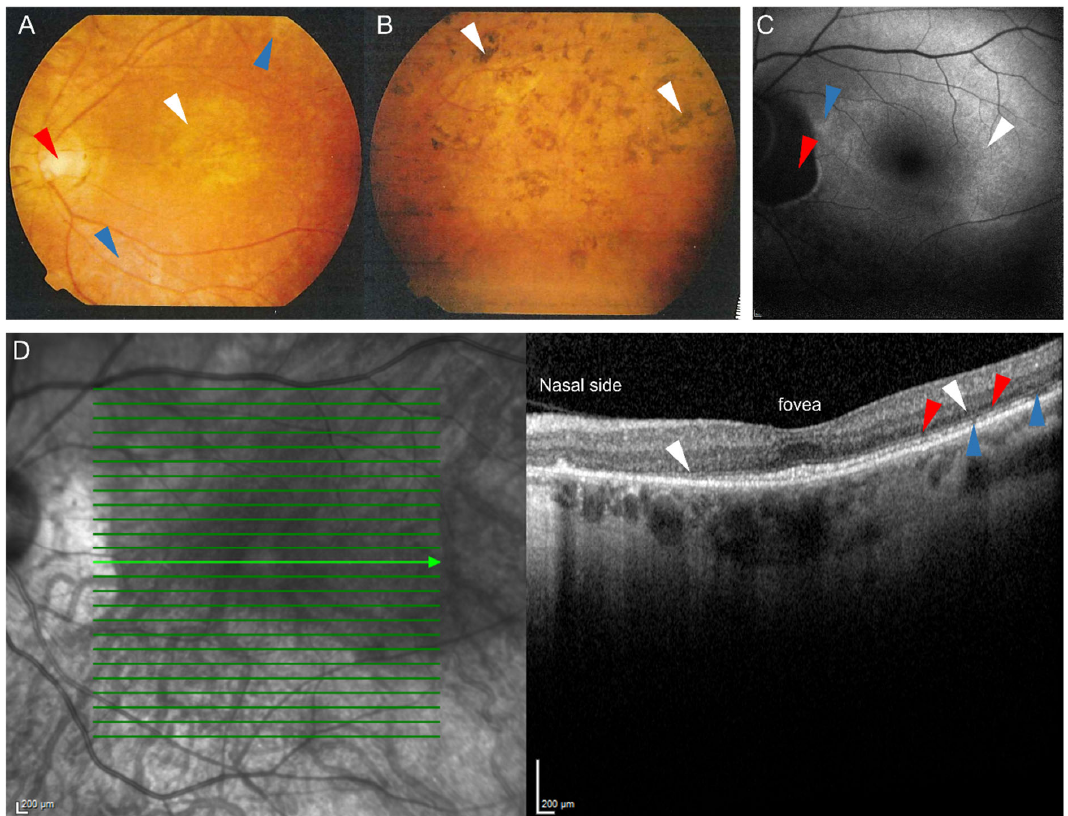
Figure 2. Representative fundus photographs ( A , B ), fundus autofluorescence image ( C ) and an optical coherence tomography (OCT) scan ( D ) of patients carrying the c.12delC mutation in LRAT suffering from LRAT ‐ associated retinal dystrophy. Fundus photograph of the central ( A ) and peripheral area ( B ) of the left eye of a 39 ‐ year old patient. ( A ): Atrophic alterations of the retinal pigment epithelium in the macula (white arrow) and around the vascular arcades (blue arrows), along with retinal atrophy around the optic disc, which shows some temporal pallor (red arrow) are visible. The vessels are attenuated. ( B ): The peripheral retina showed retinal atrophy and bone ‐ spicule ‐ like hyperpigmentation. ( C ): Fundus autofluorescence image of a 57 ‐ year old patient, showing a subtle hyperautofluorescent ring around a relatively preserved central macula (white arrow) and a juxtapapillary patch of absent autofluorescence (red arrow), sharply outlined by a hyperautofluorescent border. The inferior posterior pole shows granular hypo ‐ autofluorescence (blue arrow), indicating more atrophy of the retinal pigment epithelium in the area outside of the hyperautofluorescent ring. ( D ): Spectral ‐ domain OCT (SD ‐ OCT) scan of a 57 ‐ year old patient, showing relative preservation of the outer nuclear layers, the external limiting membrane, and the ellipsoid zone at the level of the fovea. In the parafovea and perifovea, thinning of the outer nuclear layer is seen (white arrows), along with interruptions of the external limiting membrane (red arrows) and the ellipsoid zone (blue arrows). These interruptions, along with the outer nuclear layer thinning, increase towards the peripheral macula and are more profound on the nasal side.